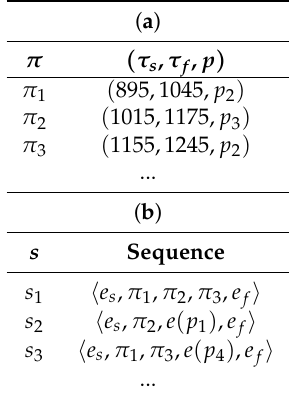
Table 3. Examples of ( a ) STP patterns; and ( b ) STP